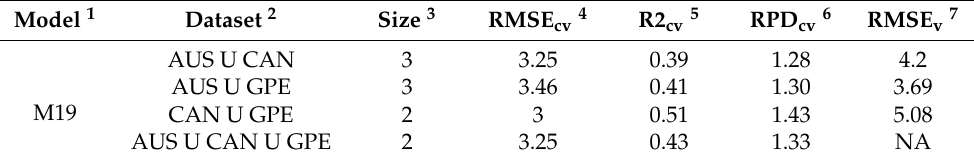
Table 4. Performance of cow-independent cross-validation and out-of-sample country-independent validation for artificial neural networks predicting the dry matter intake (in kg) of dairy